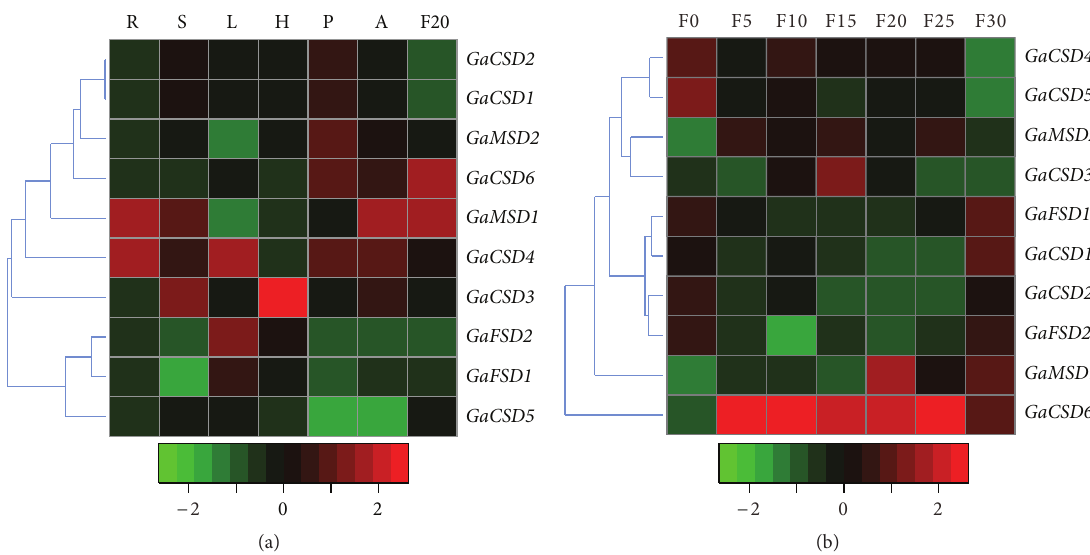
Figure 5: Expression patterns of GaSOD genes. (a) Quantitative RT-PCR of GaSOD genes in root (R), stem (S), leaf (L), hypocotyl (H), petal (P),anther(A),andfiberat20DPA(F20)ofcottonplants.(b)QuantitativeRT-PCRofGaSODgenesincottonfibersatdifferentdevelopmental stages. F0, ovules from 0DPA; F5 to F30, fibers from 5 to 30 DPA. Results were normalized using cotton UBQ7 gene expression as the internal